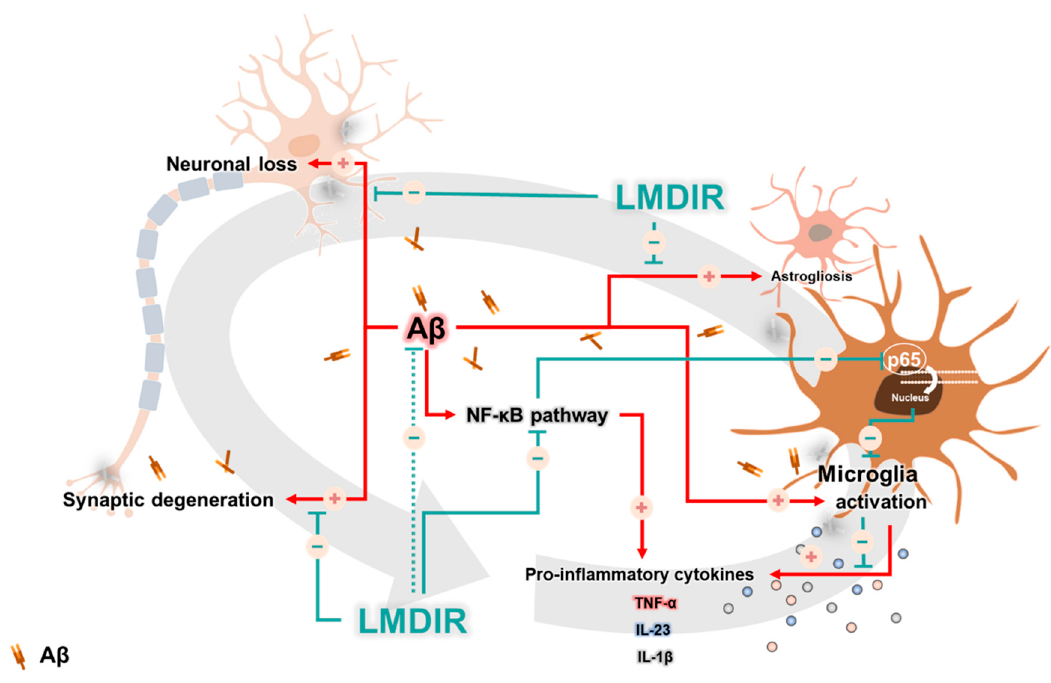
Figure 7. A possible mechanism underlying the therapeutic benefits of LMDIR treatment in AD. In the A β -overexpressing brains, a vicious cycle between neuronal loss and glial activation is established and promotes the onset of AD. A β induces neuronal loss and synaptic degeneration, and the degenerating neurons then release microglial activators, resulting in the activation of glial cells. In addition, activated microglial cells produce neurotoxic cytokines. Interestingly, the NF- κ B signaling pathway is associated with upregulation of the pro-inflammatory cytokine from glial cells. LMDIR treatment inhibits neurodegeneration and neuroinflammation by inhibiting the NF- κ B signaling pathway. Stimulatory pathways are indicated by + arrows and − arrows indicate inhibitory pathways. Low–moderate dose ionizing radiation (LMDIR); AD, Alzheimer’s disease; A β , amyloid- β ; NF- κ B, nuclear factor kappa-B.